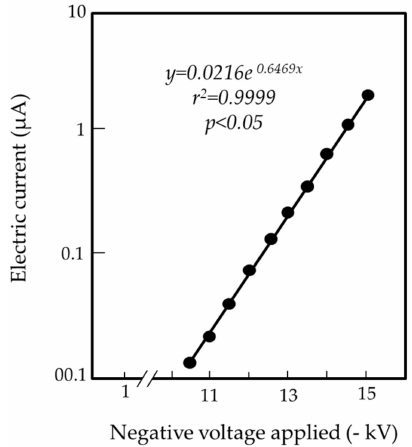
Figure 3. Relationship between the voltages applied to the insulated ring-shaped copper rod (ICR) and the current magnitudes produced in the electrostatic instrument. An exponential trend line was generated by plotting the